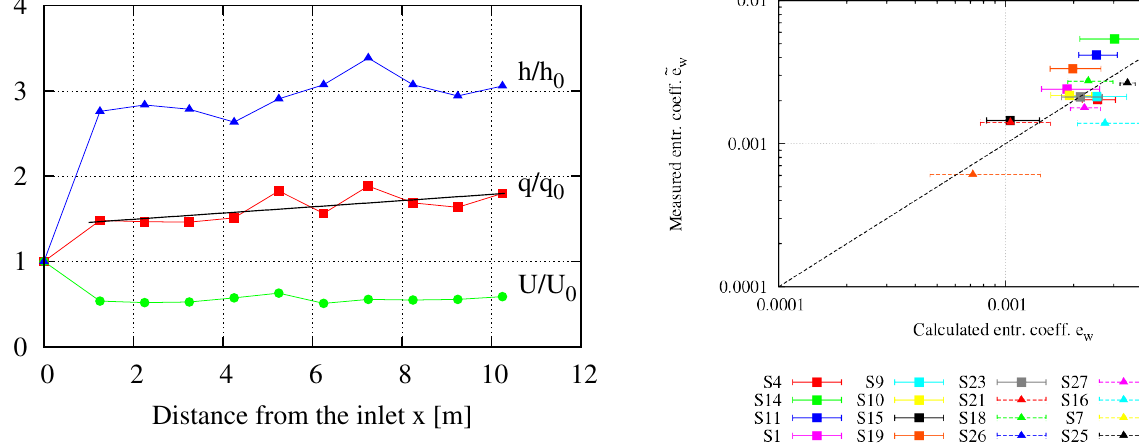
Figure 8. Comparison between the experimental value of the en- trainment (entr.) coe ffi cient ˜ e w obtained calculating the average variation of flow discharge along the straight reach and the calcu- lated value e w obtained from Eq. (6). The horizontal bars represent trainment coe ffi cient ˜ e obtained calculating the average variation the root mean square deviation associated with the spatial variability w of flow discharge along the straight reach and the calculated value of the densimetric Froude e obtained from equation (6). The horizontal bars represent the w root mean square associated with the spatial variability of the den- simetric Froude number.